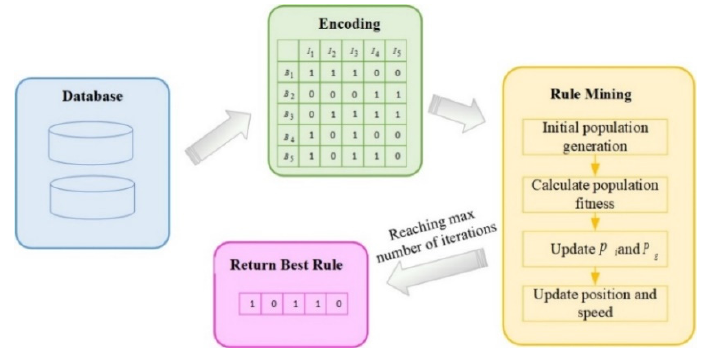
Figure 3. Association rule mining process.